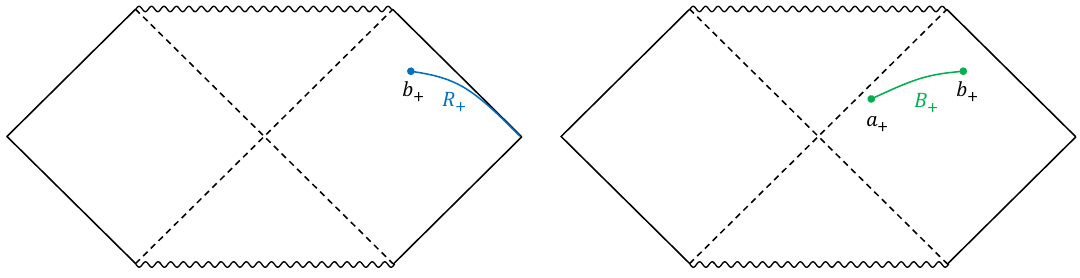
Figure 5 . The effective region of the Hawking radiation only in the right wedge R + (left) and that of the black hole (right). The entanglement entropy of R + contains no contribution from the island even after the Page time. The black hole subsystem B can also be separated into that in the right wedge B + and that in the left wedge B − . The effective region of B + does not includes the island, implying that the black hole subsystem in each side has no information of the